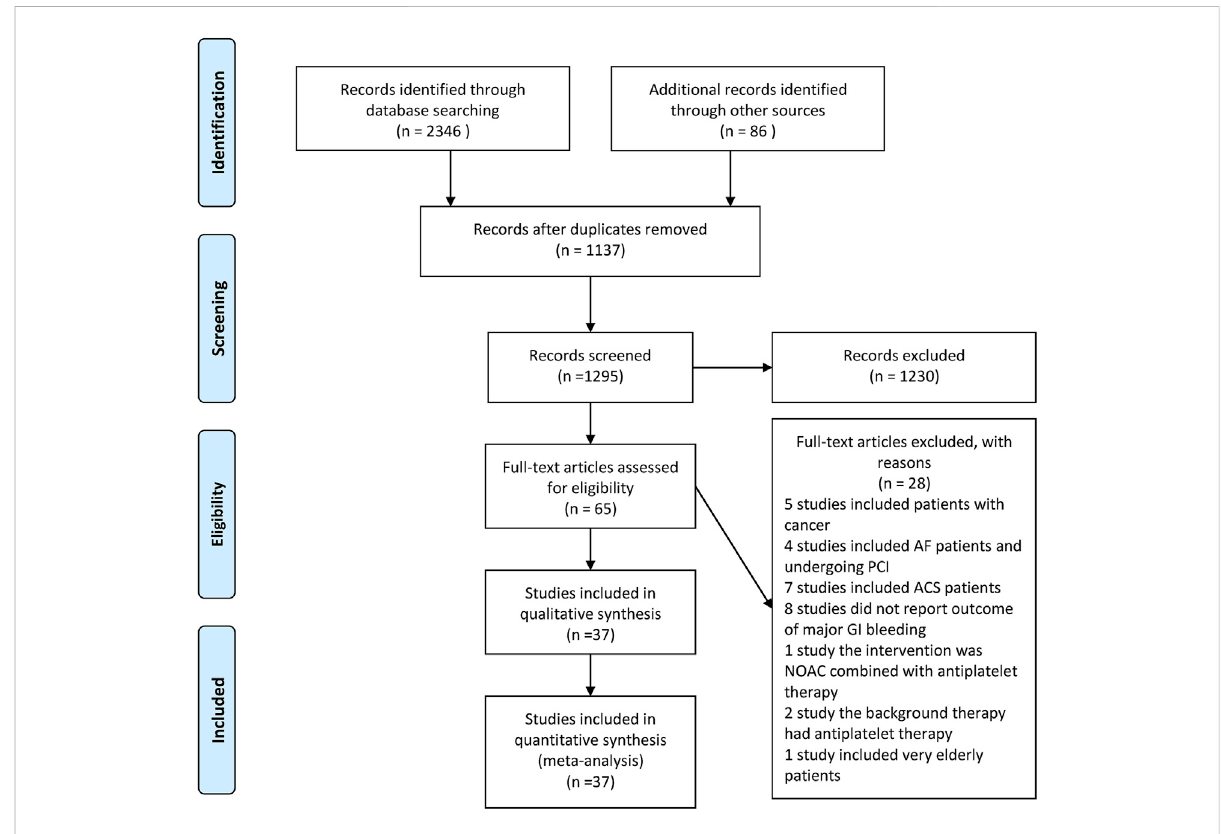
FIGURE 1 Flowchart of study screening.